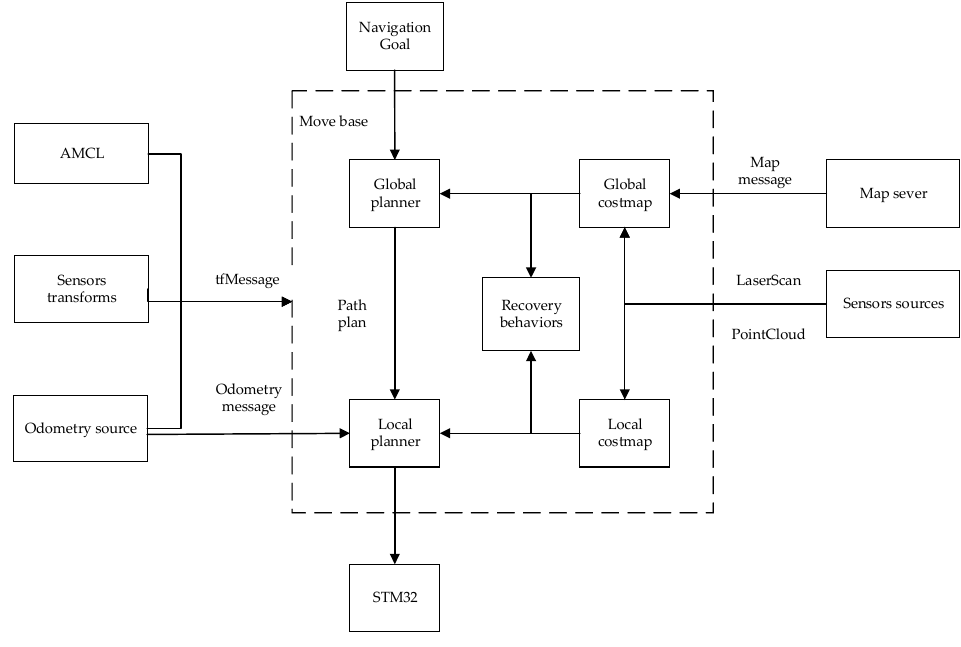
Figure 13. Navigation framework.